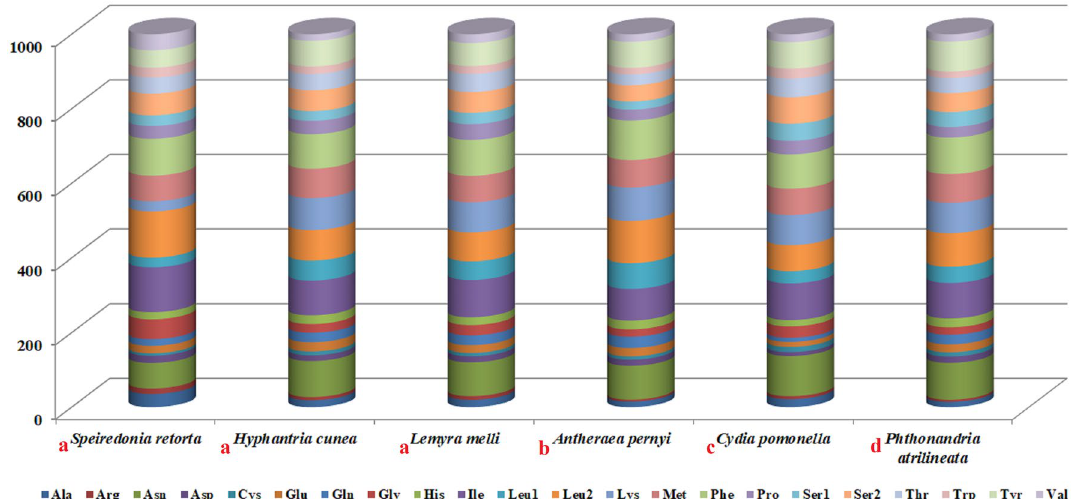
Figure 2. A comparative assessment of mitogenomic codon usage among Lepidopteran insects. Superfamily membership is indicated above species names using lowercase letters (a: Noctuoidea, b: Bombycoidea, c: Tortricoidea, d: